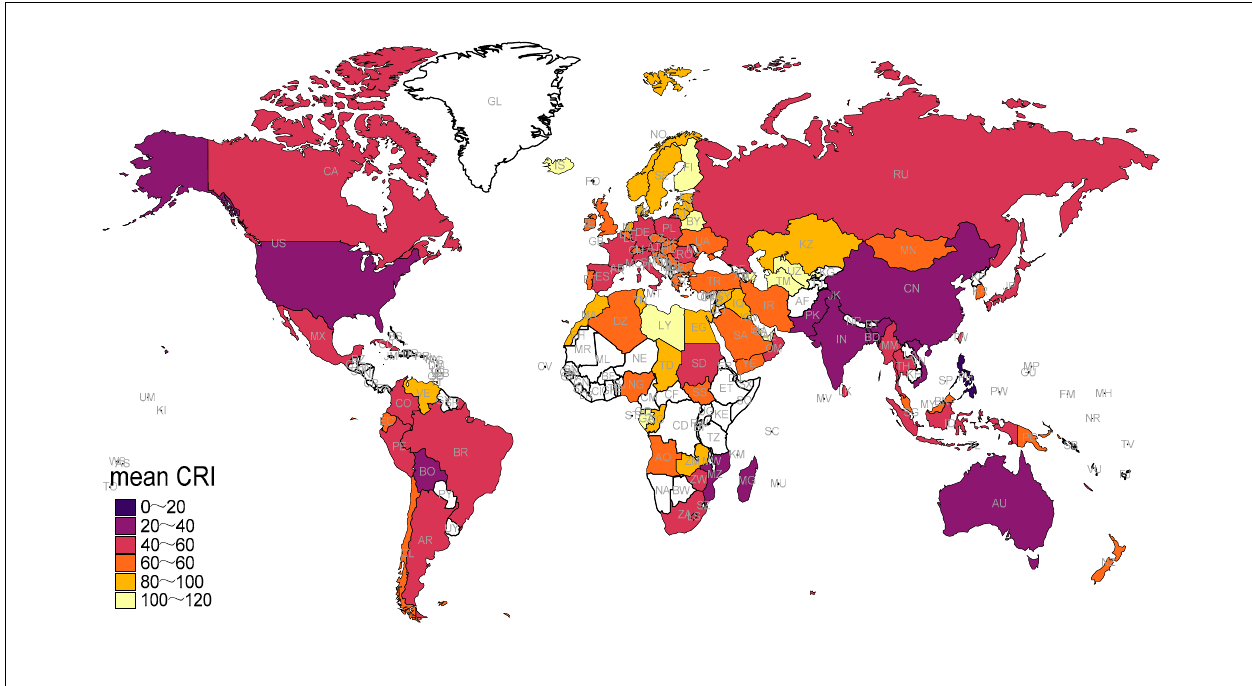
Figure 1. The mean of the climate risk index for each country.